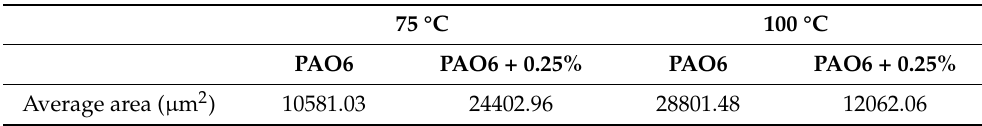
Table 2. The average wear area data of IF–WS 2 /PAO6 lubricants with different contents at different